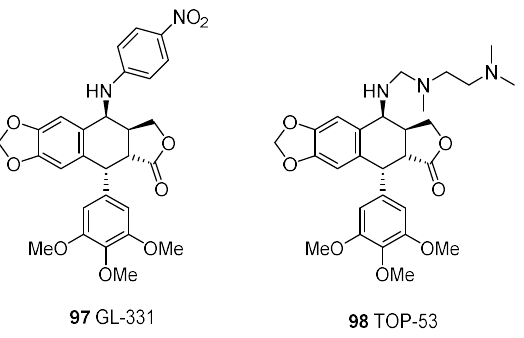
Figure 4. Chemical structures of GL-331 and TOP-53.